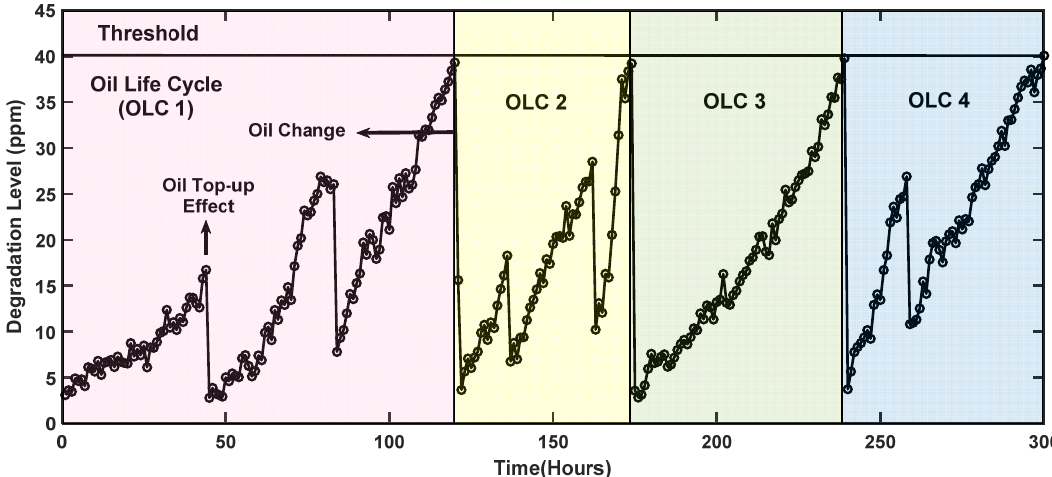
Figure 2. One of the simulated traces of the degradation level (wear debris concentration) trend with respect to time using the WDC model formulation presented in Section 2.1.